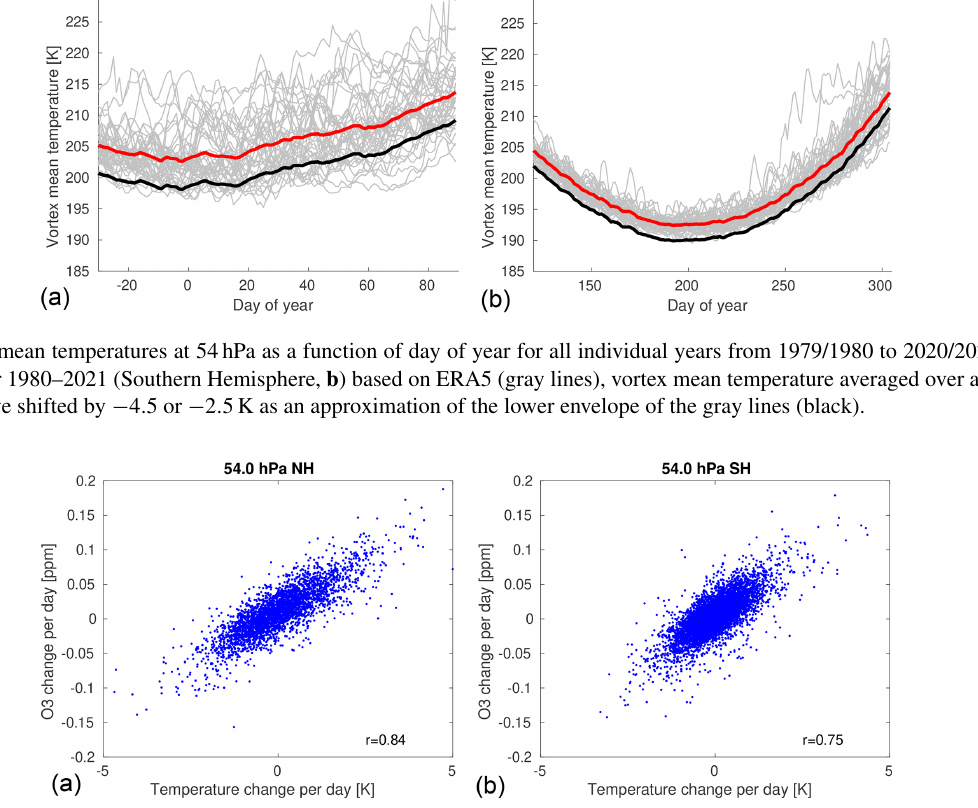
Figure 4. Scatter plot of the change of vortex-averaged ozone mixing ratio by transport per day at 54hPa for all years in ATLAS–SWIFT and corresponding change in vortex-averaged temperature per day from ERA5, corrected for the change in radiative equilibrium temperature. (a) Northern Hemisphere, (b) Southern